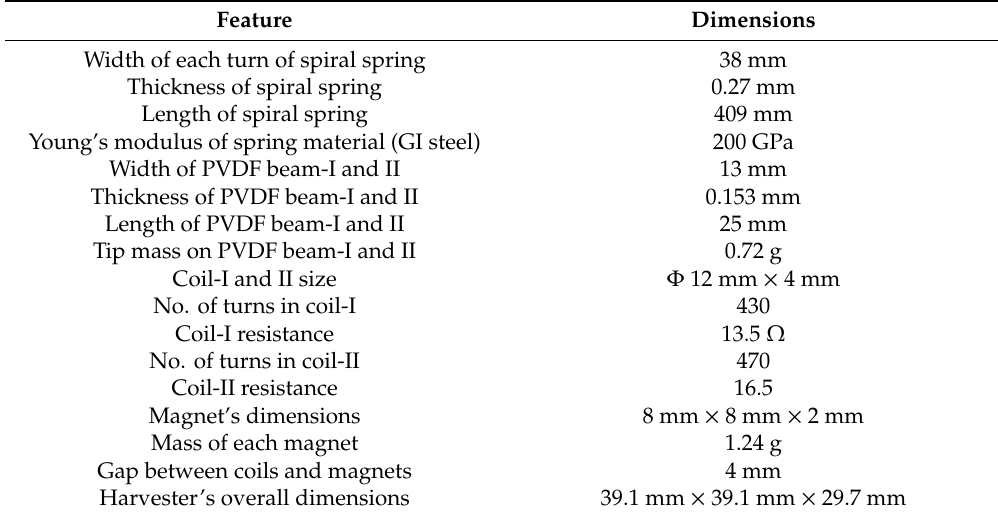
Table 3. Geometric features of the developed HIEH.